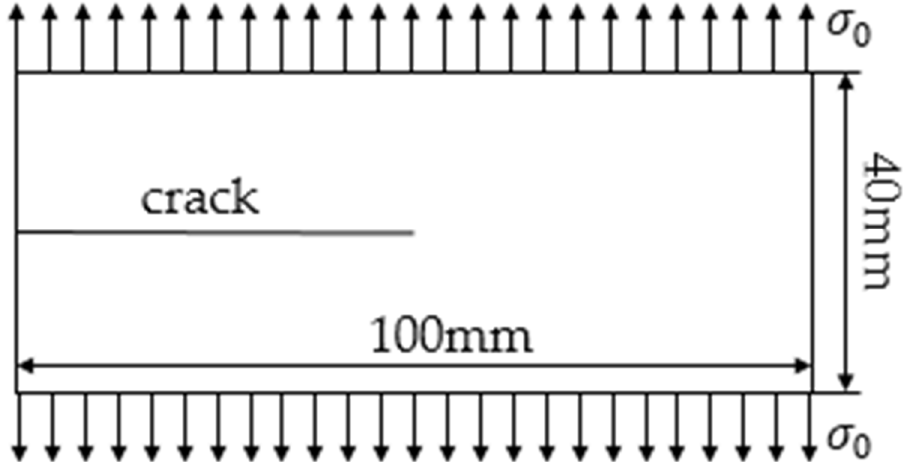
Figure 4. Model dimensions and load vector diagram.